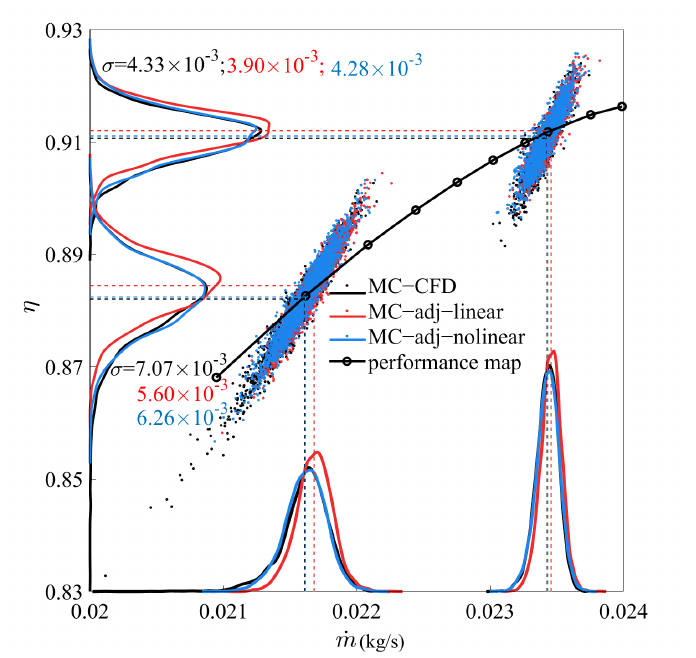
Figure 10. Performance characteristic with PDFs of mass flow rate and efficiency using the three methods. The absolute difference in a performance functional, be it mass flow rate, pressure ratio, or efficiency, between the three methods, was very small. To contrast the differences, the mean deviations of the three quantities, normalized to their respective baseline values, are shown in Figure 11. In the figure, J represents ˙ m , π , or η , the subscript 0 represents the baseline and ∆ denotes the difference in a performance functional between a sample and the